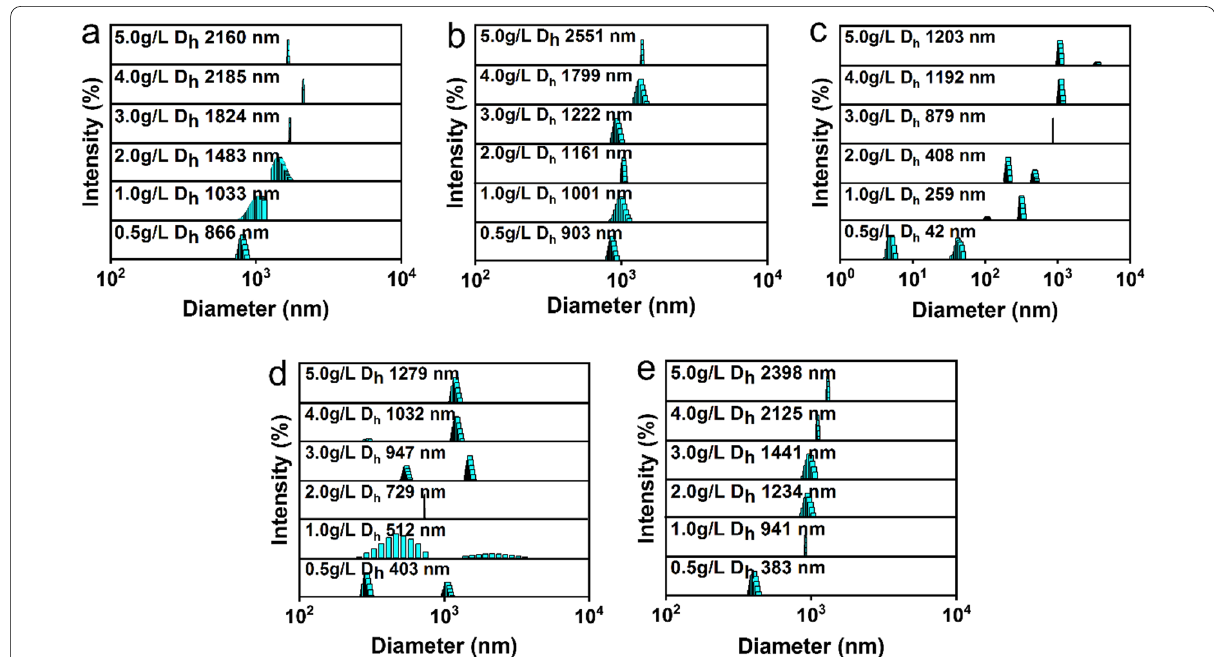
Fig. 3 Concentration dependence of the D h of Poly (AA‑co‑DAC) ( a ), Poly (AA‑co‑DMC) ( b ), Poly (AA‑co‑MAPTAC) ( c ), Poly (AA‑co‑DMAPMA) ( d ) and Poly (AA‑co‑DMAEMA) ( e ) at pI